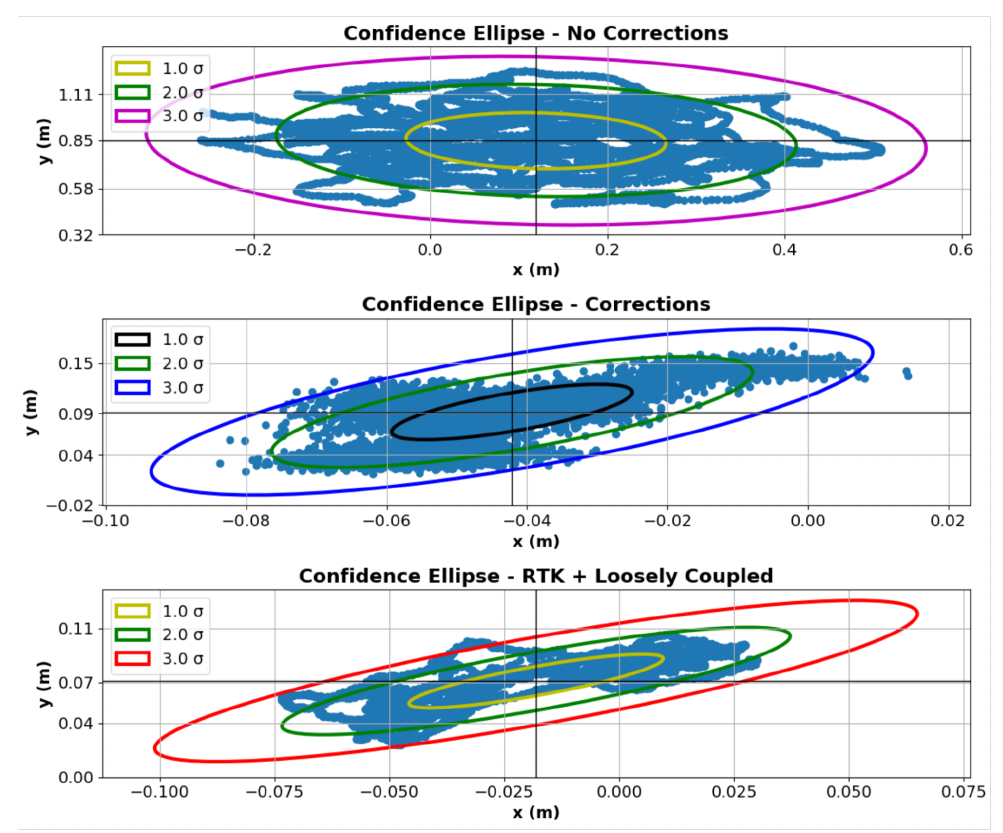
Figure 15. Confidence ellipse for GNSS data with no corrections (raw), RTK corrections and RTK + Loosely coupled